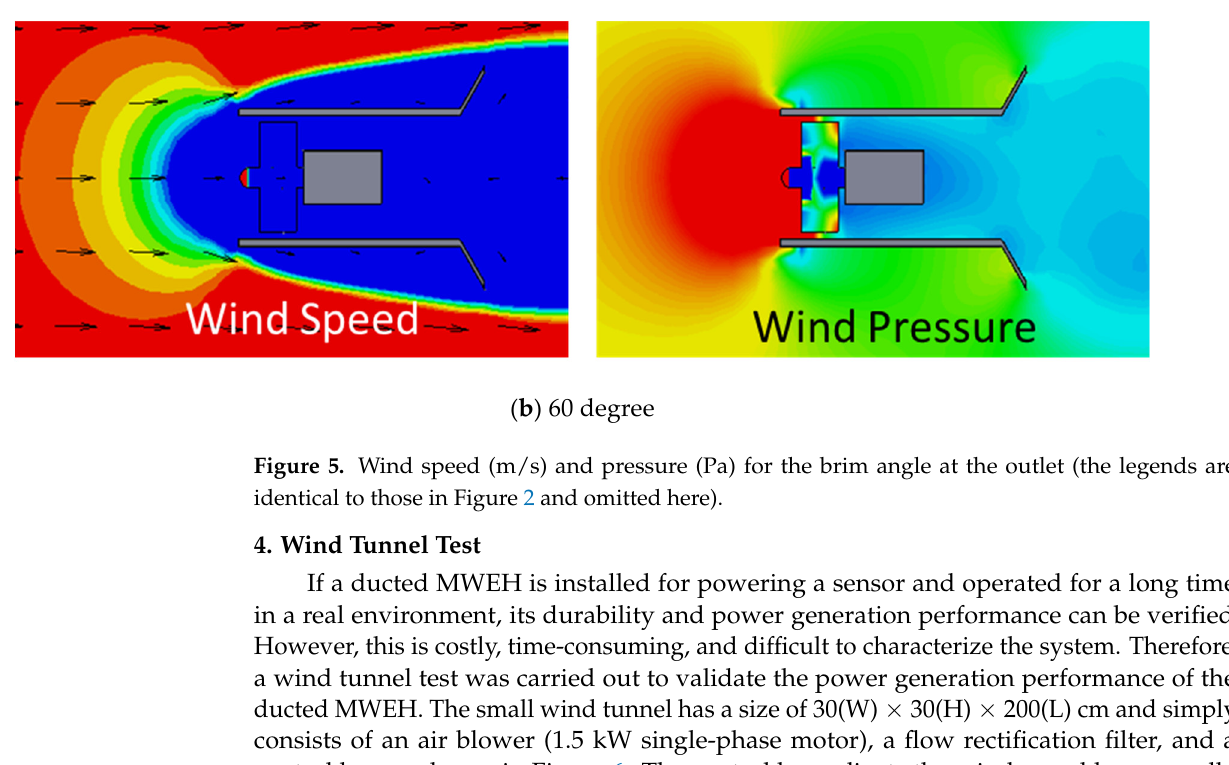
Figure 5. Wind speed (m/s) and pressure (Pa) for the brim angle at the outlet (the legends are iden- tical to those in Figures 2 and omitted here).